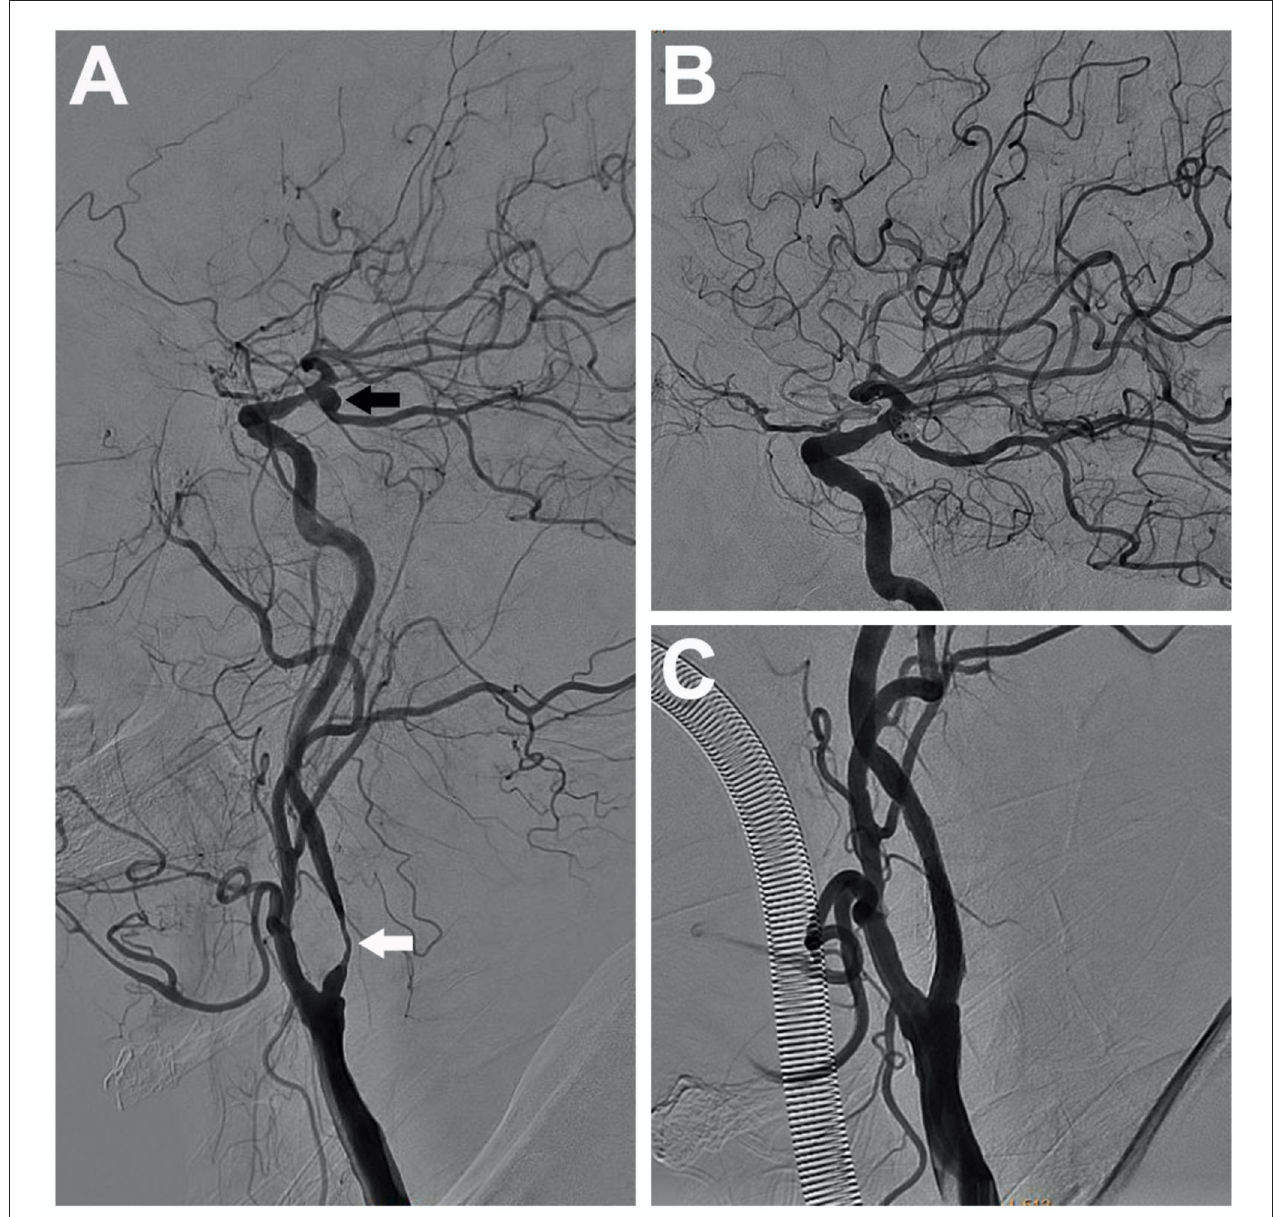
FIGURE 2 | A 70-year-old man with severe stenosis in the left internal carotid artery (the white arrow) coexisted with an ipsilateral unruptured posterior communicating aneurysm (the black arrow), measuring 5mm (A) . A single-stage endovascular procedure was implemented. After stent placement of the left internal carotid artery, stent-assisted embolization of the ipsilateral tandem aneurysm was applied. After single-stage treatment, left common carotid artery and internal carotid artery angiograms showed complete aneurysm exclusion (B) and satisfactory carotid revascularization (C)